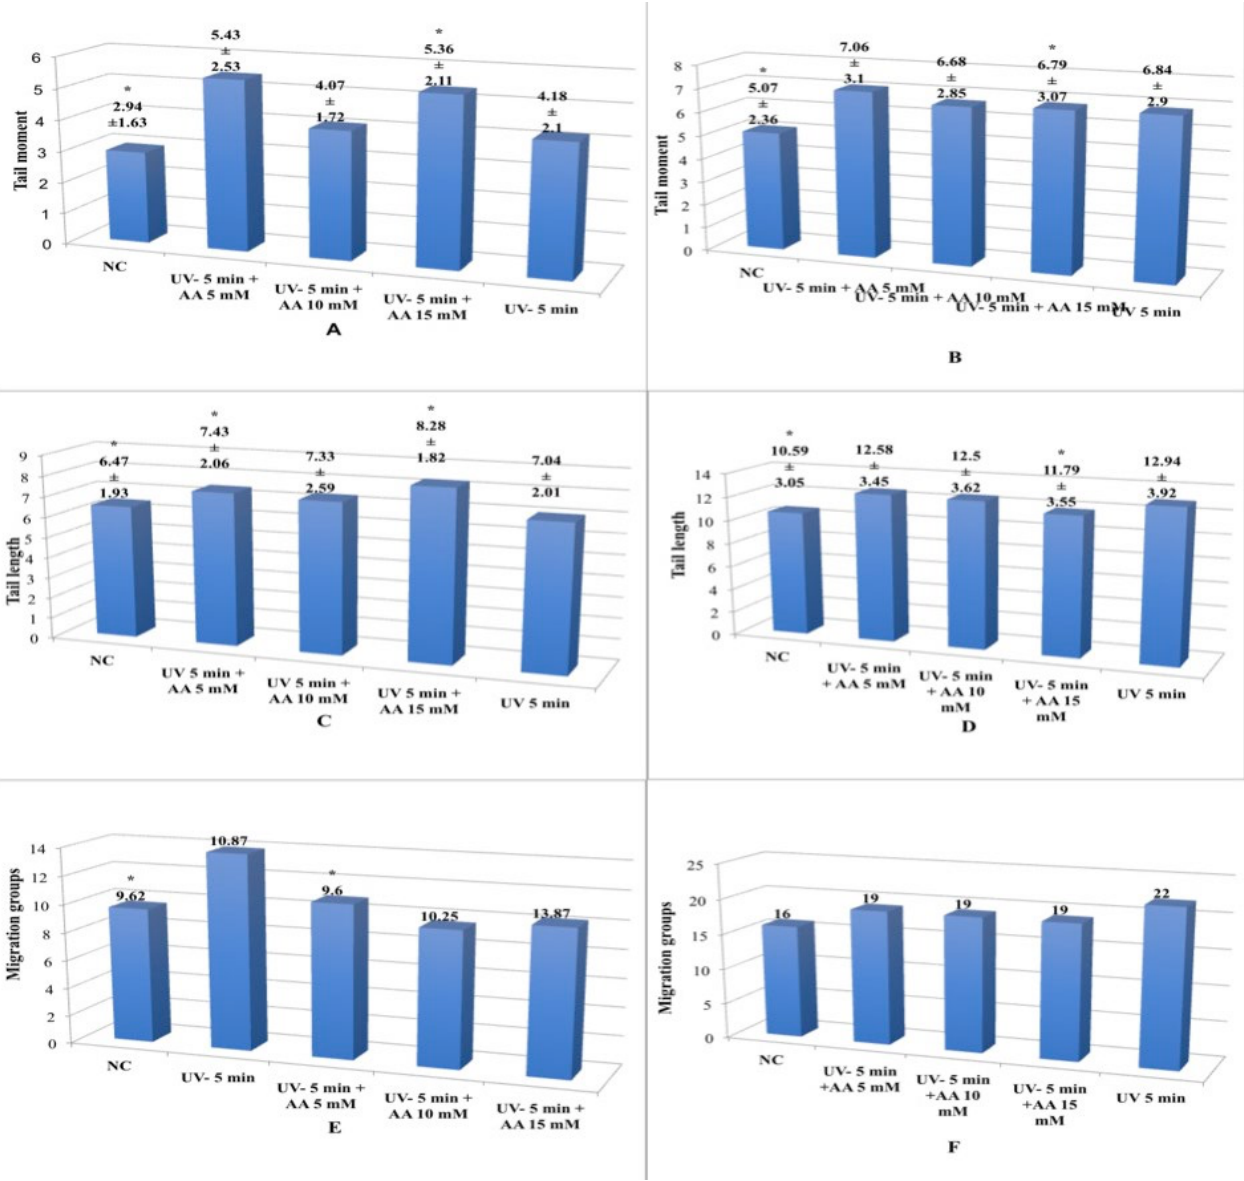
Figure 2. Genetic damage observed using the parameters: tail moment, tail length, and MGs in comet cells of Oreochromis niloticus ( A , C , E ) and Ambystoma mexicanum ( B , D , F ) exposed post-treatment to UV-C 5 min (PC) and UV-C + AA. * Significant differences ( p < 0.05) regarding the negative control.